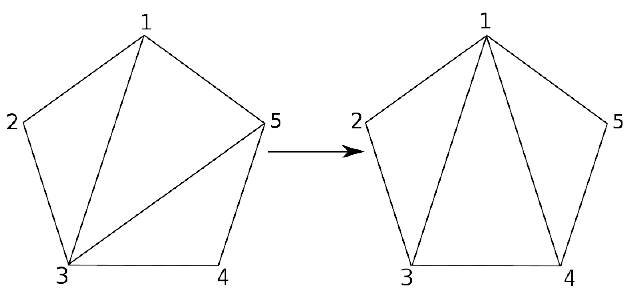
Figure 8. The classical monodromy action in the ( A 1 ; A 2 ) theory, which rotates the triangulation of the pentagon clockwise by 2 units, is equivalent to a single (cid:13)ip which replaces the 35 edge by a 14